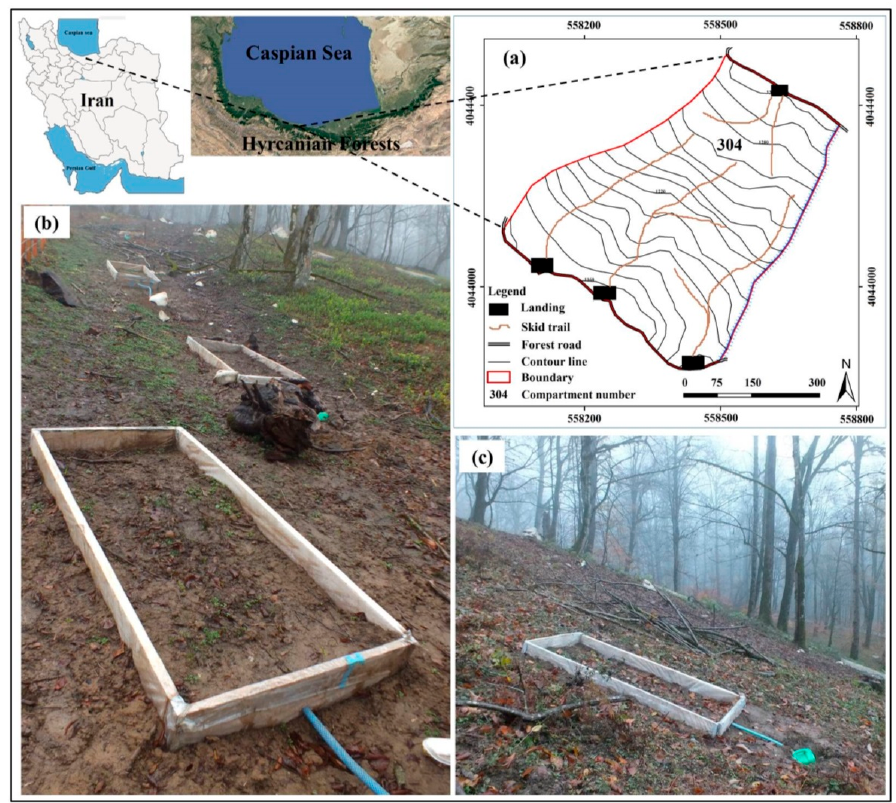
Figure 1. ( a ) Location of the study area in the Hyrcanian forest, Northern Iran. ( b ) Runoff plot establishment on the different slope gradient of the skid trail segment, ( c ) runoff plot on the slope gradient of 35%.